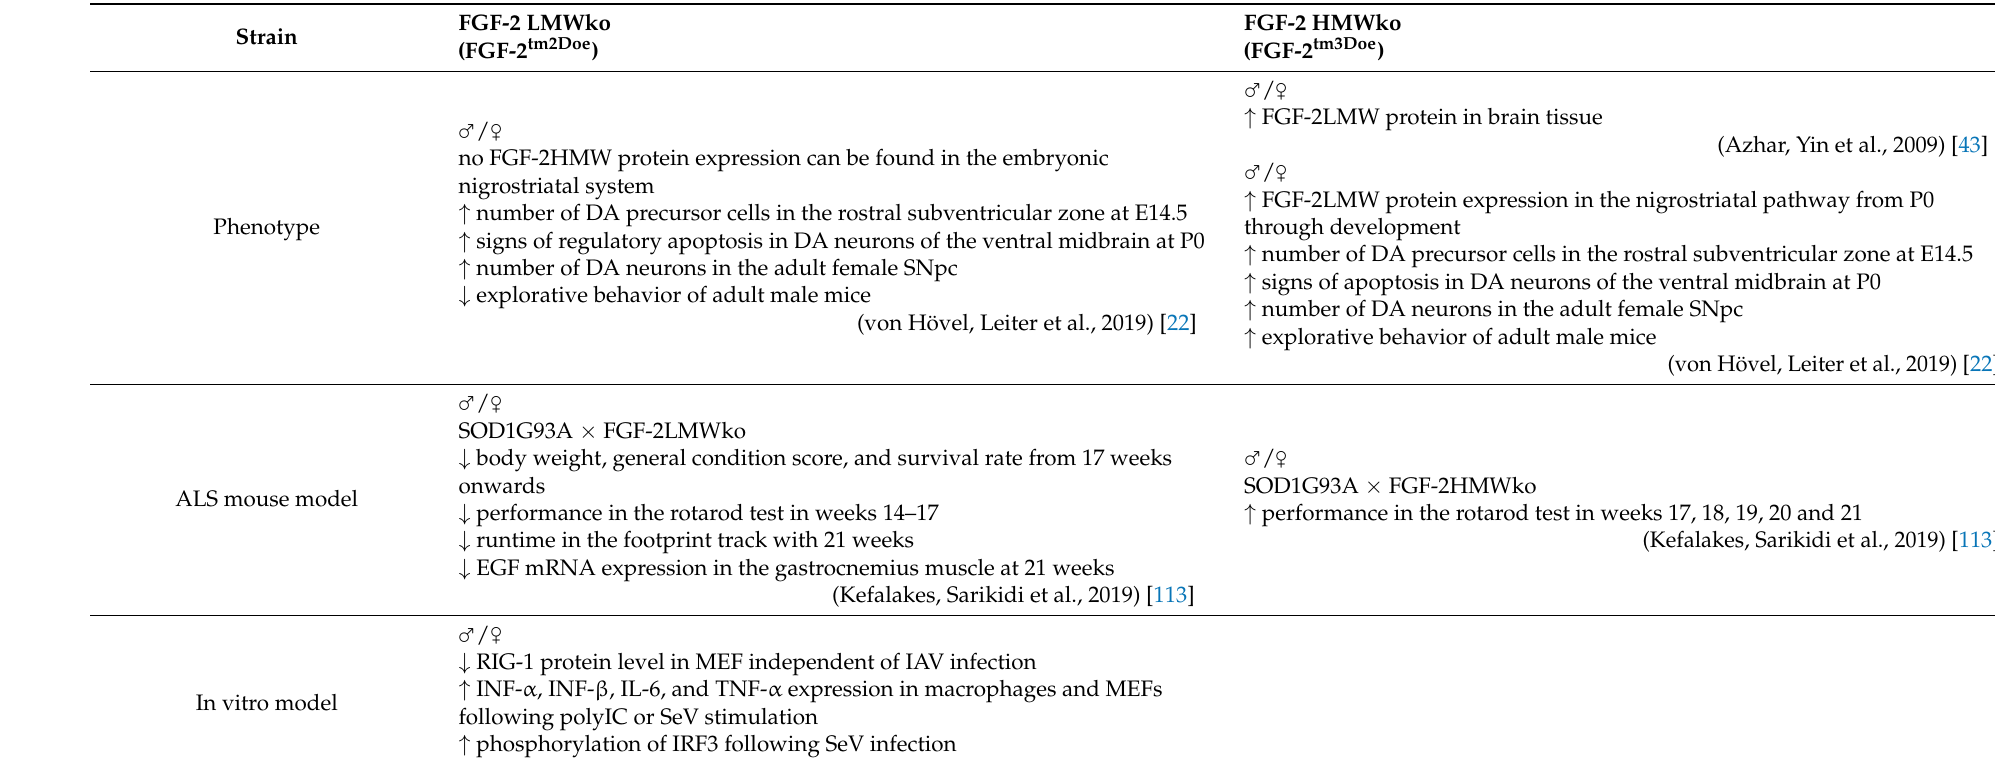
(Kefalakes, Sarikidi et al., 2019)